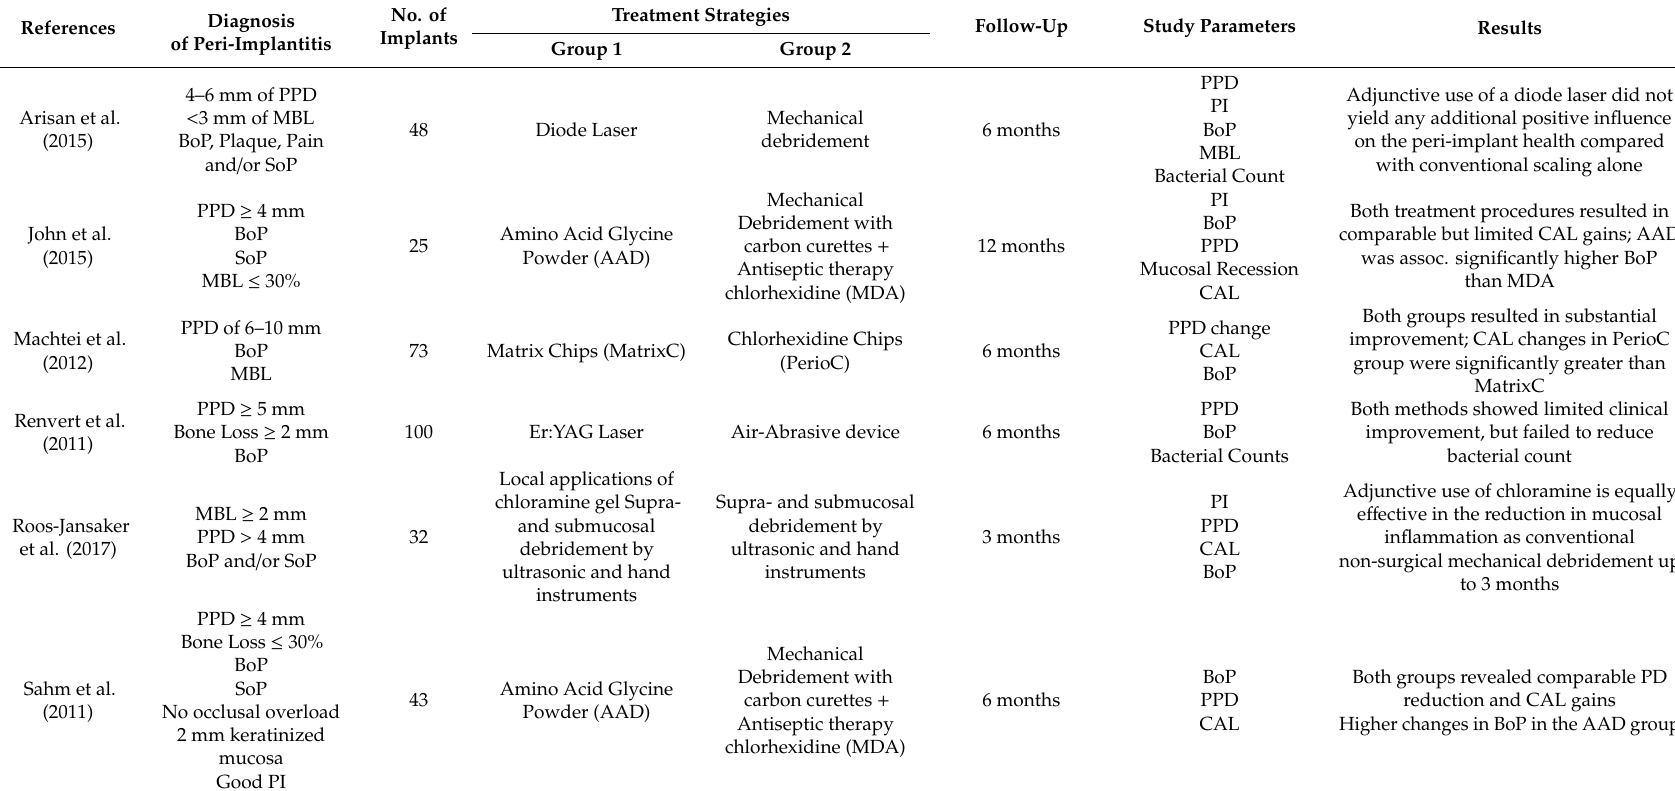
Table 6. Summary of non-surgical